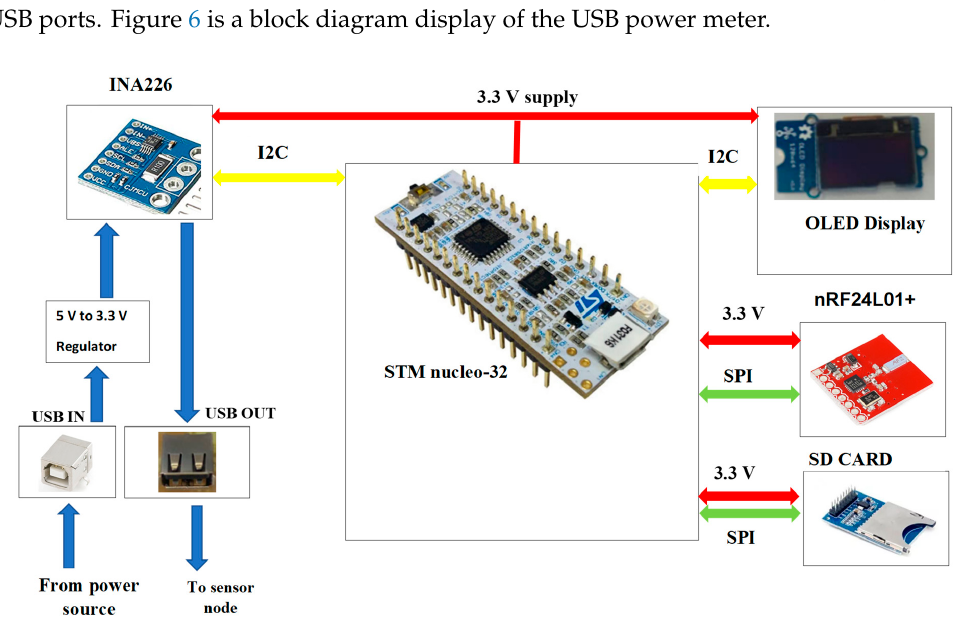
Figure 6. Block diagram of power measurement device.